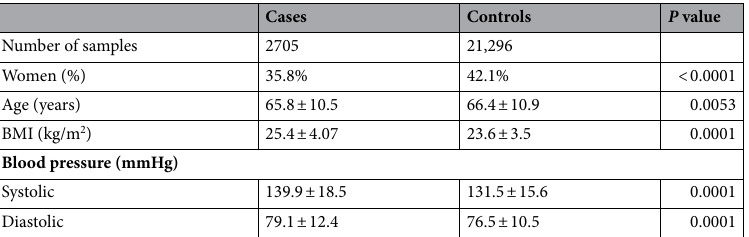
Supplementary Table S11. After quality-control and PCA described in detail below, Japanese subjects compris- ing 2705 cases and 21,296 controls were used to conduct a GWAS. The demographics of the study subjects at enrollment are summarized in Table 2. We incorporated age and sex as covariates for GWAS as described below. However, we did not use body mass index (BMI) as a covariate because of a large number of missing data of BMI near the prescription date in the study population.